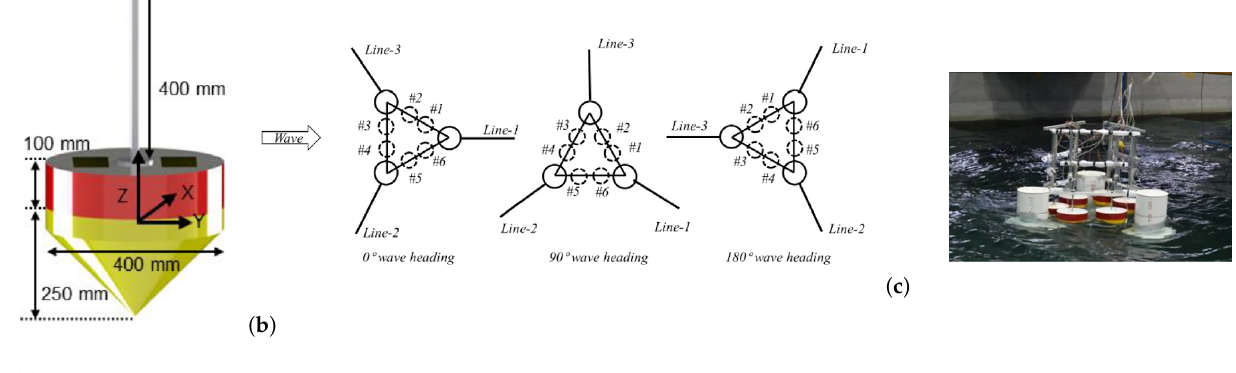
Figure 17. Experimental setup used by Sun et al., reprinted with permission from Ref. [54], 2021, Sun et al.: ( a ) 3D model of the WEC buoy with dimensions; ( b ) towing tank WEC array layout; ( c ) National Ocean Technology Center’s towing tank